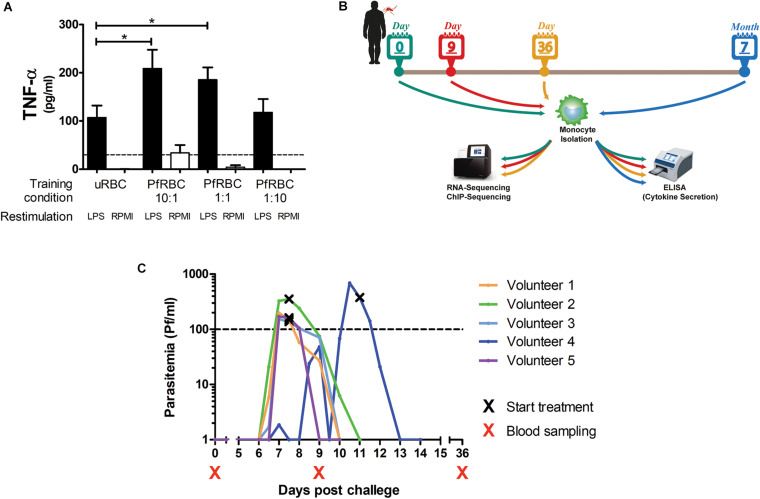
Controlled Human Malaria Infection induces lasting changes in monocytes. (A) Adherent monocytes from 6 healthy donors were seeded at 0.1 × 106/well and pre-incubated with uninfected red blood (uRBC) cells at a concentration or 1× 106/well, or P. falciparum infected red blood cells (PfRBC) at a concentration of 1 × 106/well, 0.1 × 106/well or 0.01 × 106/well for 24 h. After 5 days resting in normal medium, monocytes were restimulated with 10 ng/mL LPS (black bars) or RPMI as a negative control (white bars) for 24 h. The graph shows TNF-α concentrations measured in supernatants by ELISA. P-values are the result of Wilcoxon matched-pairs signed rank test, *p < 0.05. (B) Five healthy volunteers were infected with P. falciparum by mosquito bite challenge, blood was sampled at baseline (before infection), and 9 and 36 days, and 7 months after infection. (C) The graph shows the parasitemia as determined by twice daily qPCR starting on day 6 after challenge for each individual volunteer. All volunteers were treated when parasitemia reached 100Pf/mL. Four volunteers were treated on day 7 after challenge and one volunteer on day 11 after challenge. *p < 0.05.